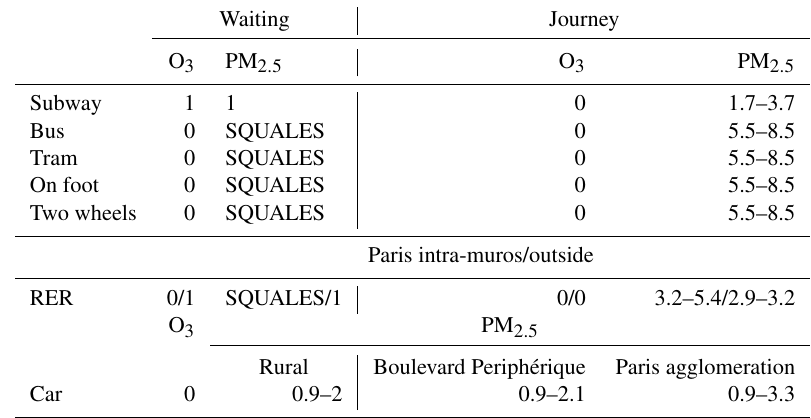
Table 3. O 3 and PM 2 . 5 indoor / outdoor ratios for the principal means of